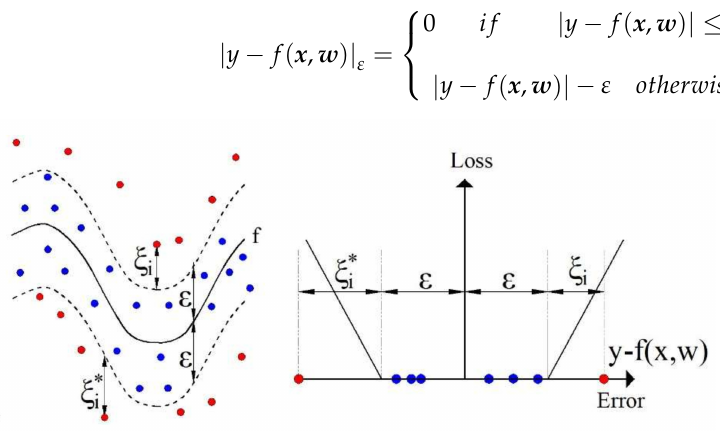
Figure 7. Nonlinear SVR with linear loss function with an ε -insensitivity